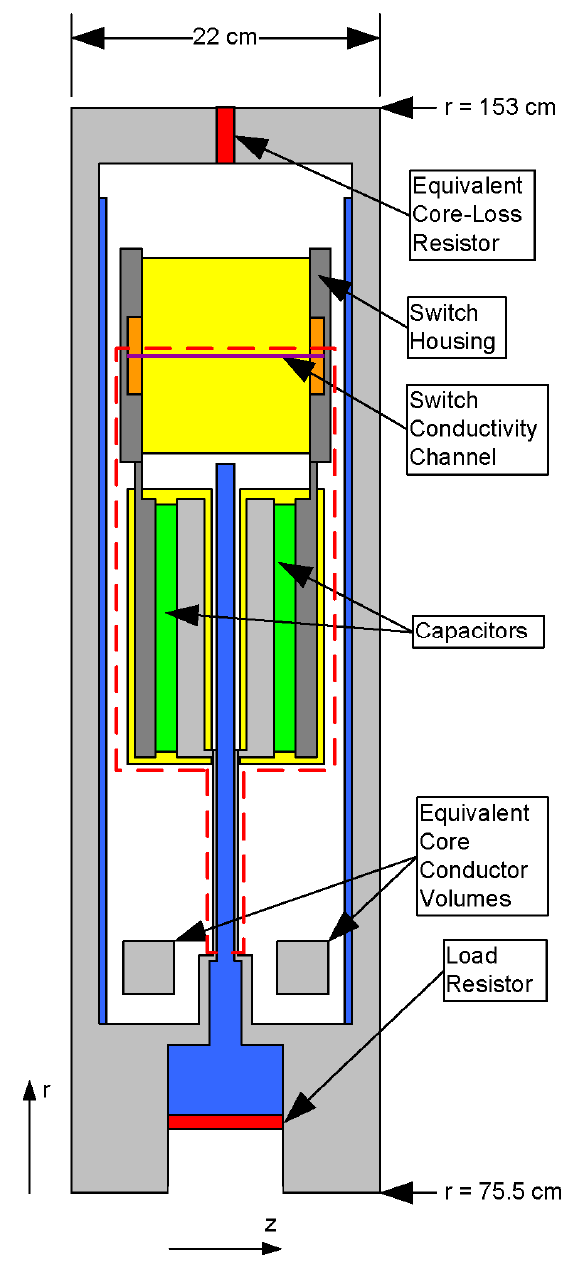
FIG. 2. (Color) Schematic of the 3D LSP simulation geometry used for the single-cavity analysis. The figure shows the azimu- thal plane passing through the center of the switch and capaci- tors. The simulation model is periodic in (cid:1) between 0 and (cid:2)= 20 radians. The dashed red line indicates the approximate brick current path used in the estimation of the mutual